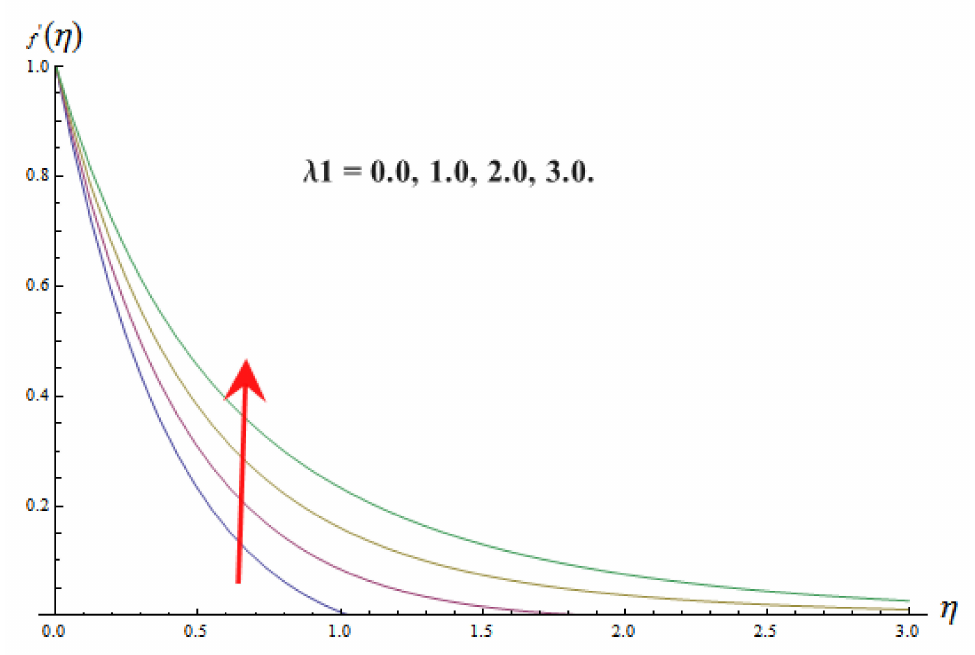
Figure 4. Impact of λ 1 on f (cid:48) ( η ) keeping Γ = 0.5, Pr = 2, Br = 2, λ = 2, Ec = 0.2, Rd = 2, β 1 = 0.2, Ha = 2, K ∗ =